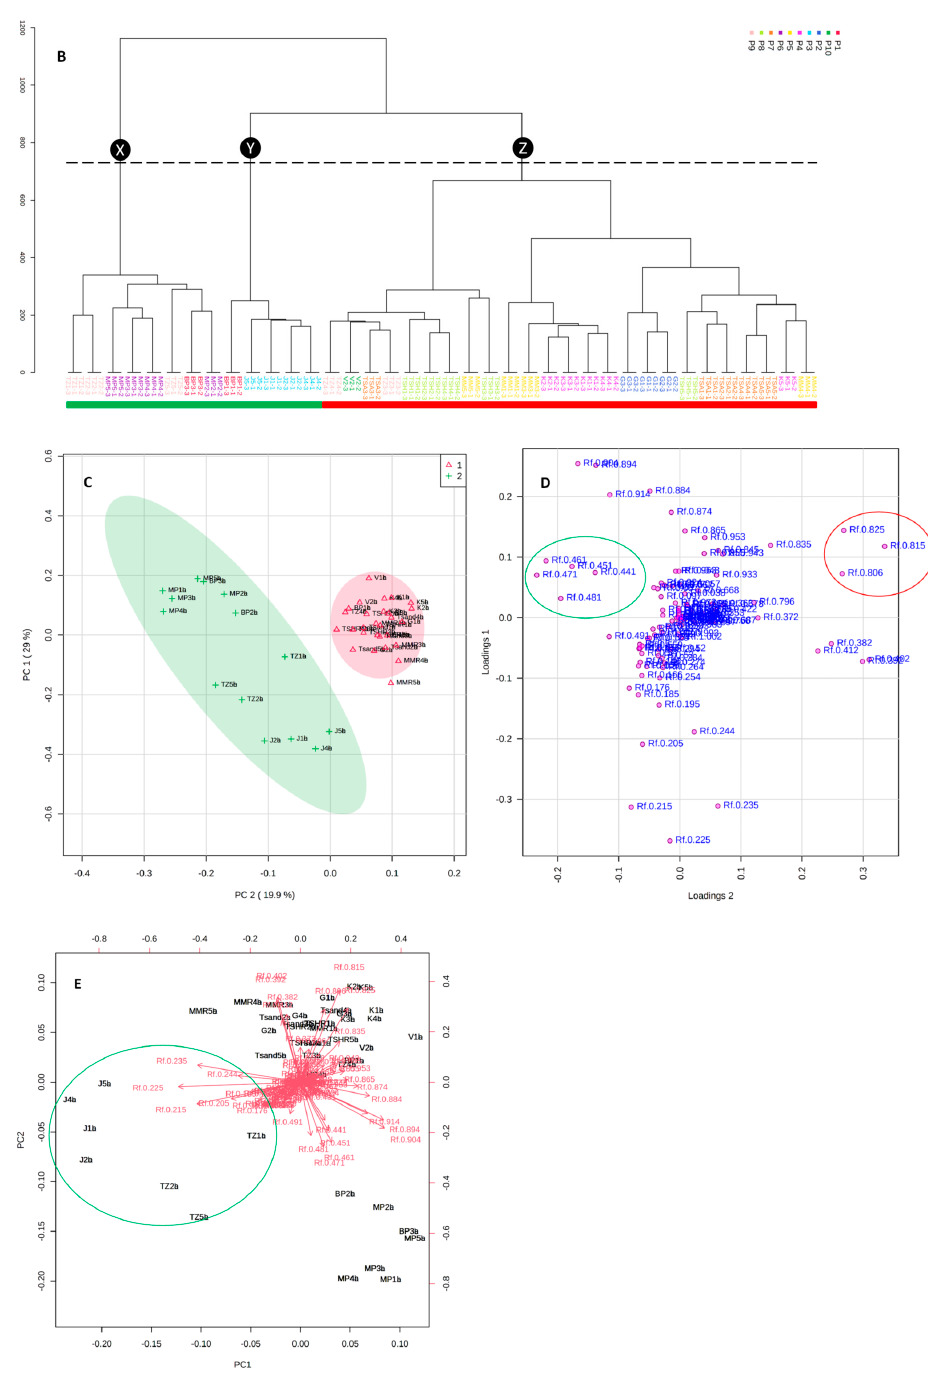
Figure 4. ( A ) Dendrogram obtained from the HCA of the rTLC data, emphasizing the chemical consistency within the populations, ( B ) dendrogram obtained from the HCA of the UPLC-MS data, with a clustering pattern similar to that obtained with the HPTLC data (Figure 4A) although samples J1–J4 and BP2 and 3 (Branch Y) are clustered separately from MP1-MP5 and TZ1, 2 and 5 (Branch X), ( C ) the scores plot coloured according to the HCA (HPTLC data), ( D ) the loadings plot indicating potential markers (HPTLC data), and E ) the biplot (HPTLC data) indicating the associa- tion of compounds with samples (resveratrol-3- O - β -rutinoside to samples J1–J4 and TZ1–2 and TZ5). Samples found in the green clusters (Figure 4A–E) have a high concentration of sericic acid (except samples J1–J4) while samples within the red cluster contain a high concentration of serico- side.